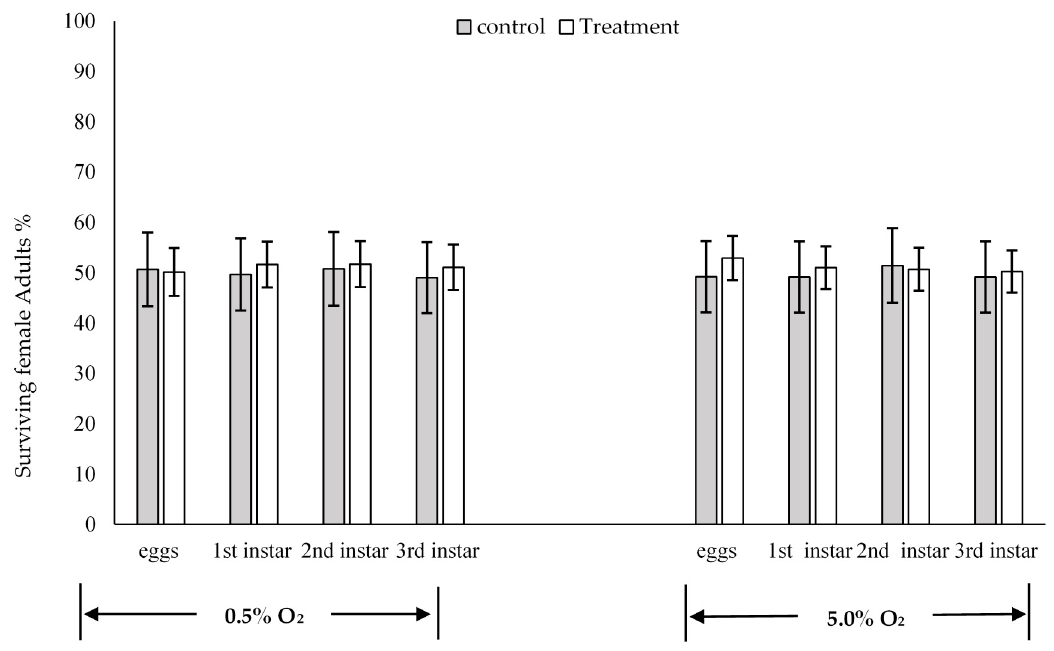
Figure 4. Percentage of surviving adult females under 0.5% O 2, and 5.0% O 2 . Error bars represent the standard error of the mean. An ANOVA single factor test was used to compare sex ratios, p > 0.05.